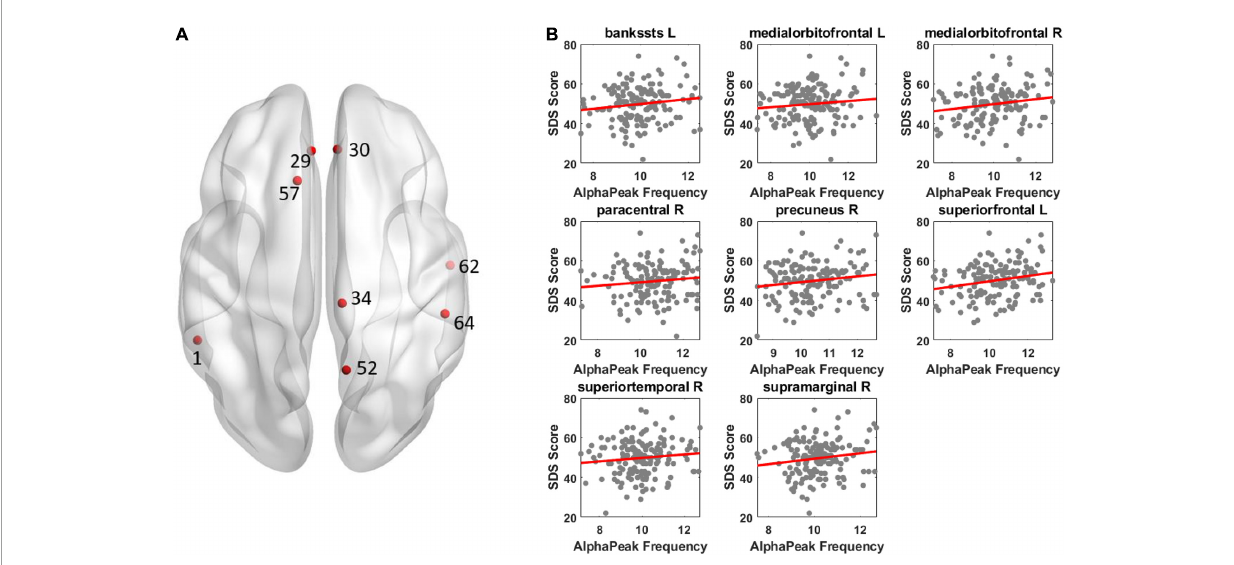
FIGURE4 Illustration of correlation results between alpha peak frequency and depressive score. The results revealed a positive correlation between alpha peak frequency and depressive score. Other conventions are as in Figure 3 .